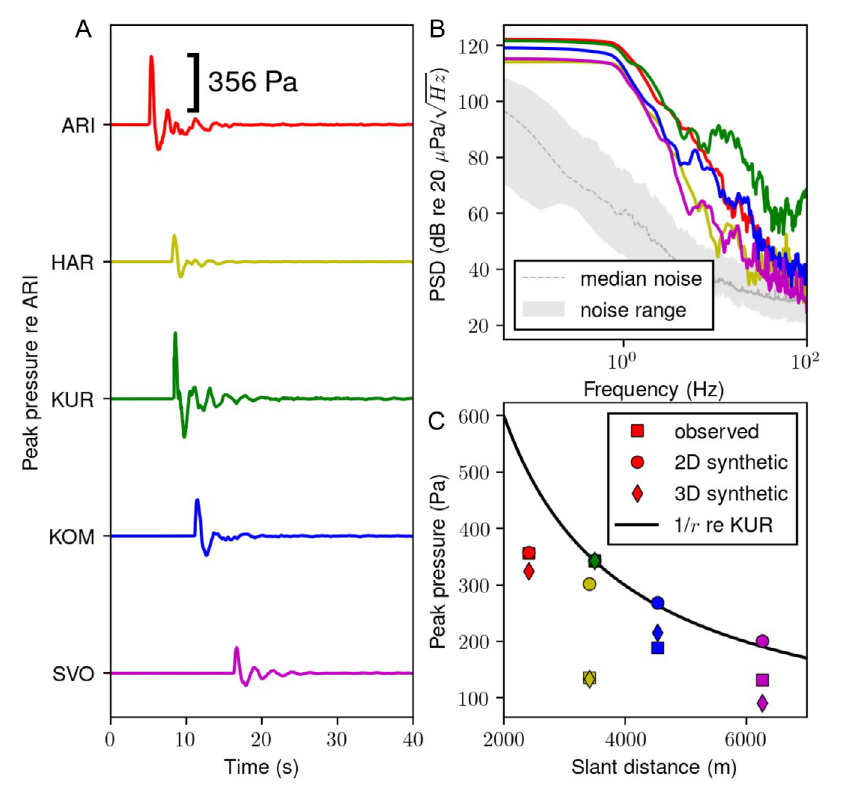
[A] Example of ob- served waveforms for one event at Sakurajima at 23:06:56.960 on 07/20/2013 (UTC). Amplitudes are normalized by the maximum at ARI (356 Pa) for ease of plot- ting. [B] Multitaper PSD esti- mates for the waveforms in Fig- ure 7A (original waveform ampli- tudes). The grey shaded region indicates the noise range across the network as defined by the 5 th and 95 th percentiles of network- averaged PSD curves for 50 % overlapping hourly time-windows during the deployment [Maher et al. 2020]. The dashed grey line is the median noise condition (50 th percentile). [C] Peak pressure vs distance for the waveforms in Fig- ure 7A (squares). The peak pres- sures for 2D simulations with to- pography (circles), 3D simulations with topography (diamonds). The synthetic and predicted ampli- tudes are scaled to match the observed KUR amplitude. Black line represents expected ampli- tude decay from spherical spread- ing based on KUR amplitude. This example is one out of 30 events used to construct the boxplots in Figure